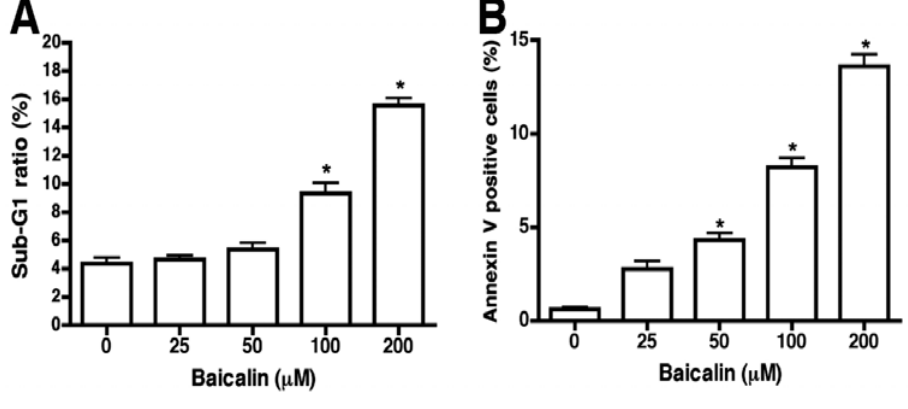
Figure 3. Quantification of sub-G1 cells in SW620 cells treated with baicalin. SW620